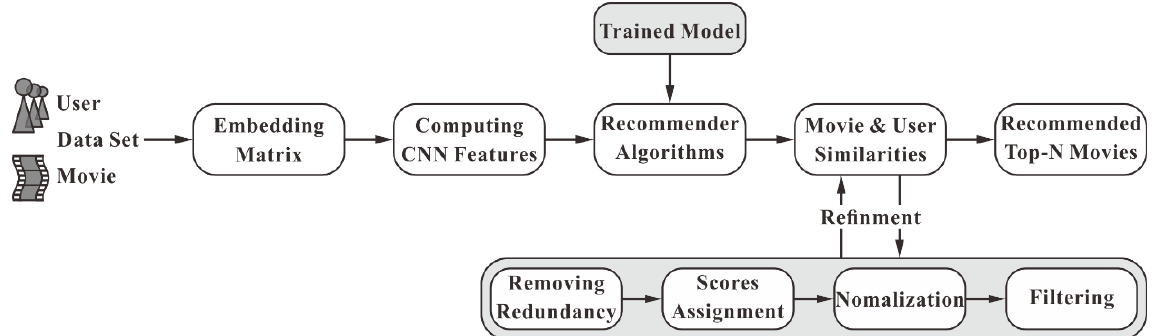
Figure 2. The framework of the movie recommendation system with deep